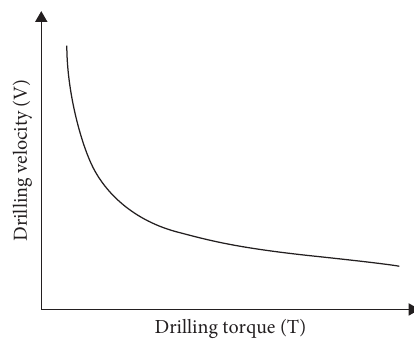
Figure 11: Curve of rate of penetration against drilling torque under fixed drilling power.